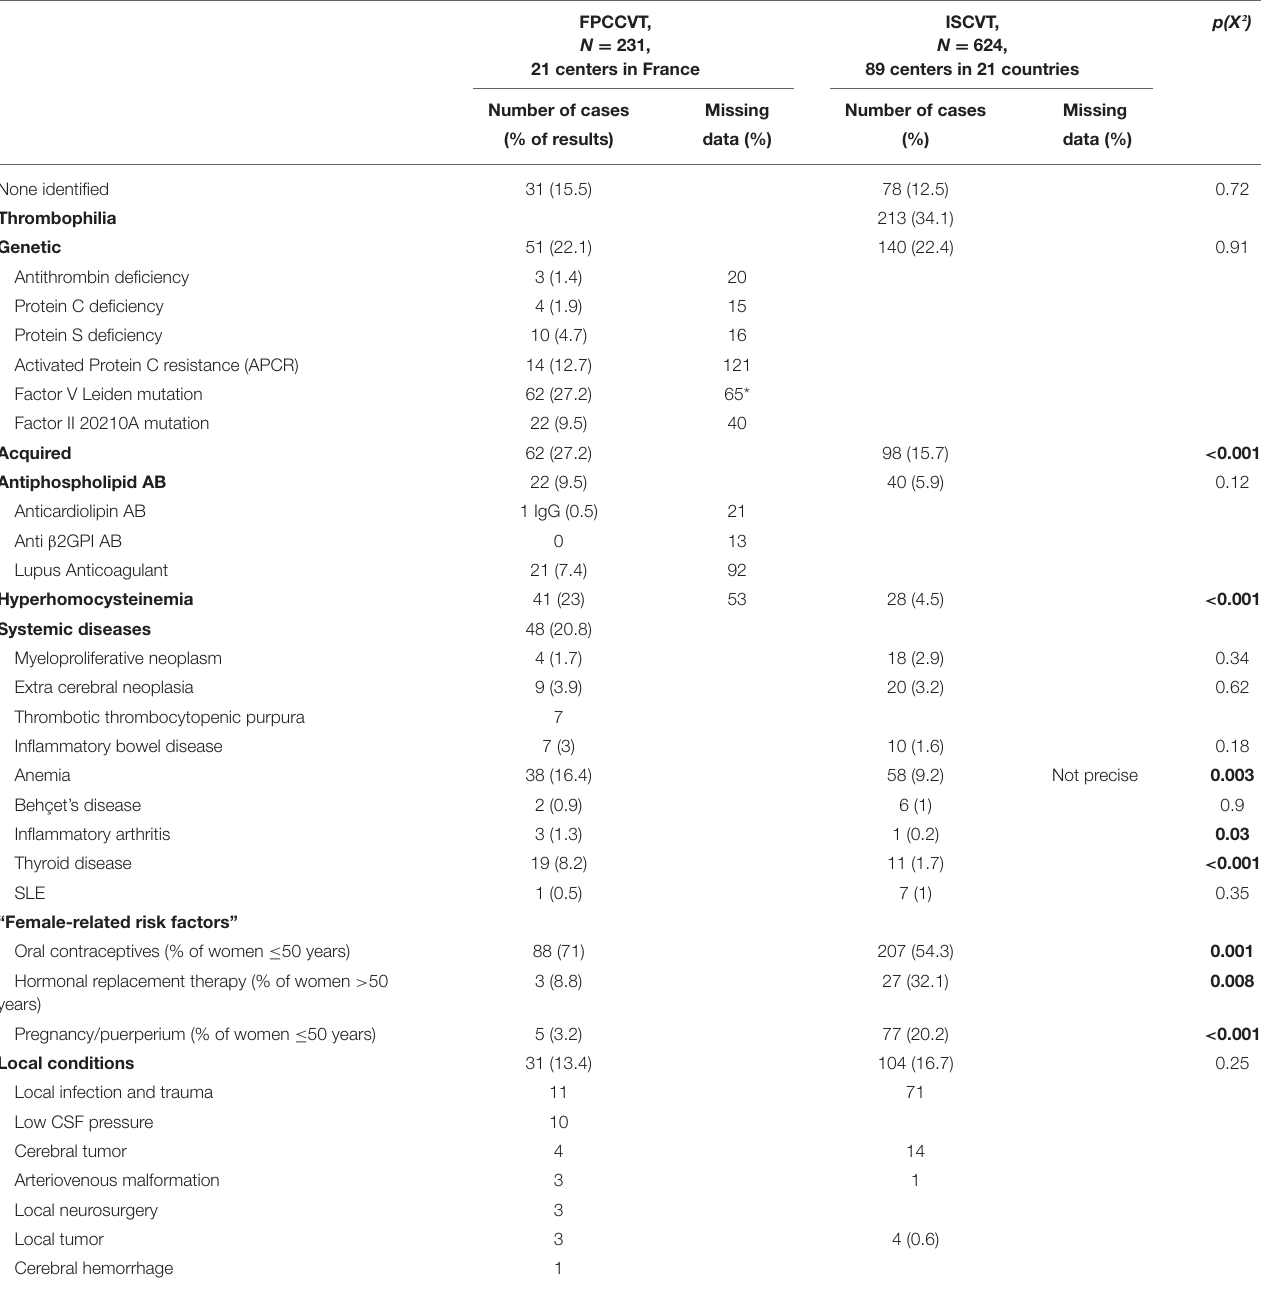
TABLE 5 | Etiological characteristics of the FPCCVT and ISCVT